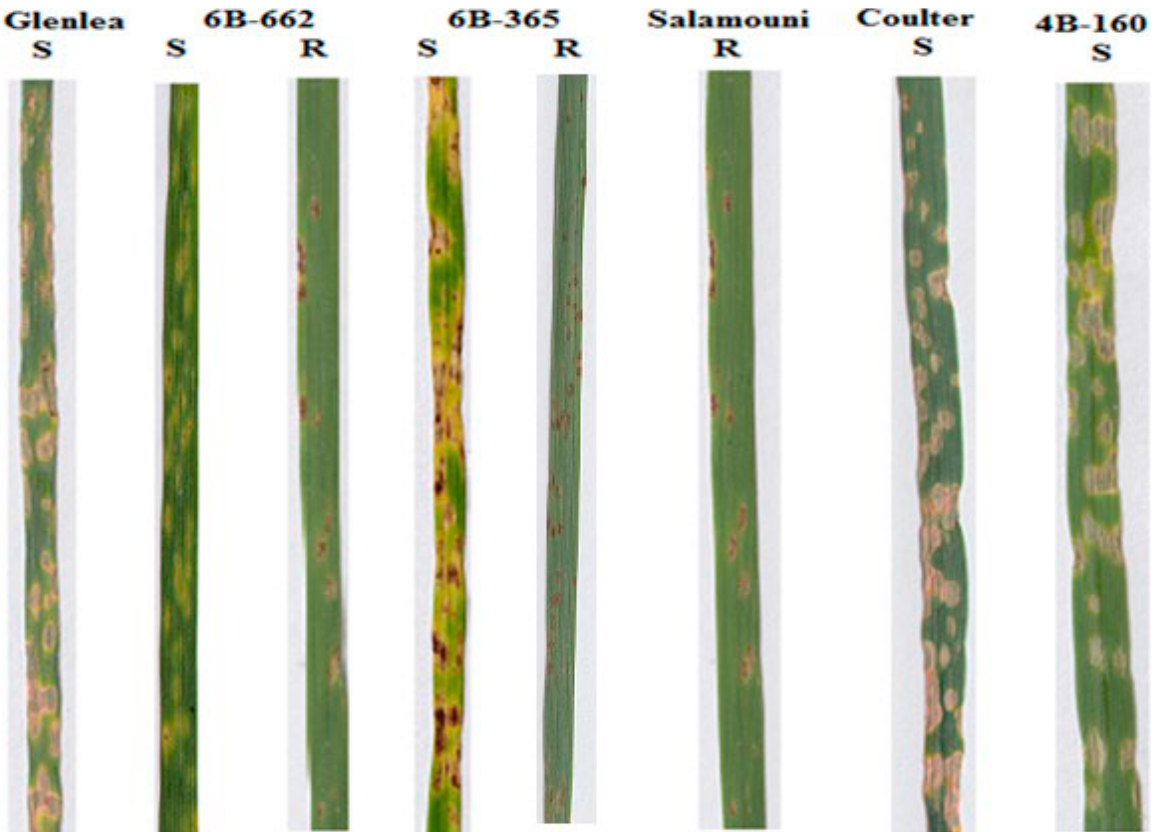
Figure 2. Representative resistant (R) and susceptible (S) reactions of wheat cvs. ‘Glenlea’, ‘Salmouni’, ‘Coulter’ and lines 6B662, 6B365 and 4B-160, to inoculation with isolates of Pyrenophora tritici-repentis. ‘Glenlea’ developed tan necrosis (S) when inoculated with Tunisian isolates classified as races 2, 7 or 8. Line 6B662 developed chlorosis (S) in response to inoculation with isolates of races 5, 6, 7 or 8. Line 6B365 devel- oped chlorosis (S) when inoculated with Tunisian isolates classified as races 6 or 8. ‘Coulter’ developed necrosis (S) when inoculated with races 2, 5, 6, 7 or 8. Line 4B-160 developed necrosis (S) when inoculated with race 5. ‘Salamouni’ was resistant (R) to all identified